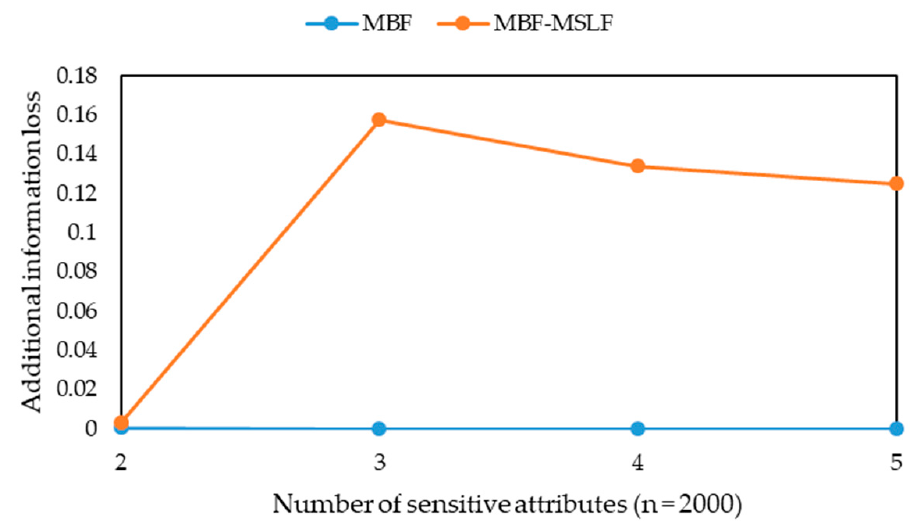
Figure 5. The additional information loss of MBF and MBF-MSLF with di ff erent sensitive attribute numbers ( n = 2000).